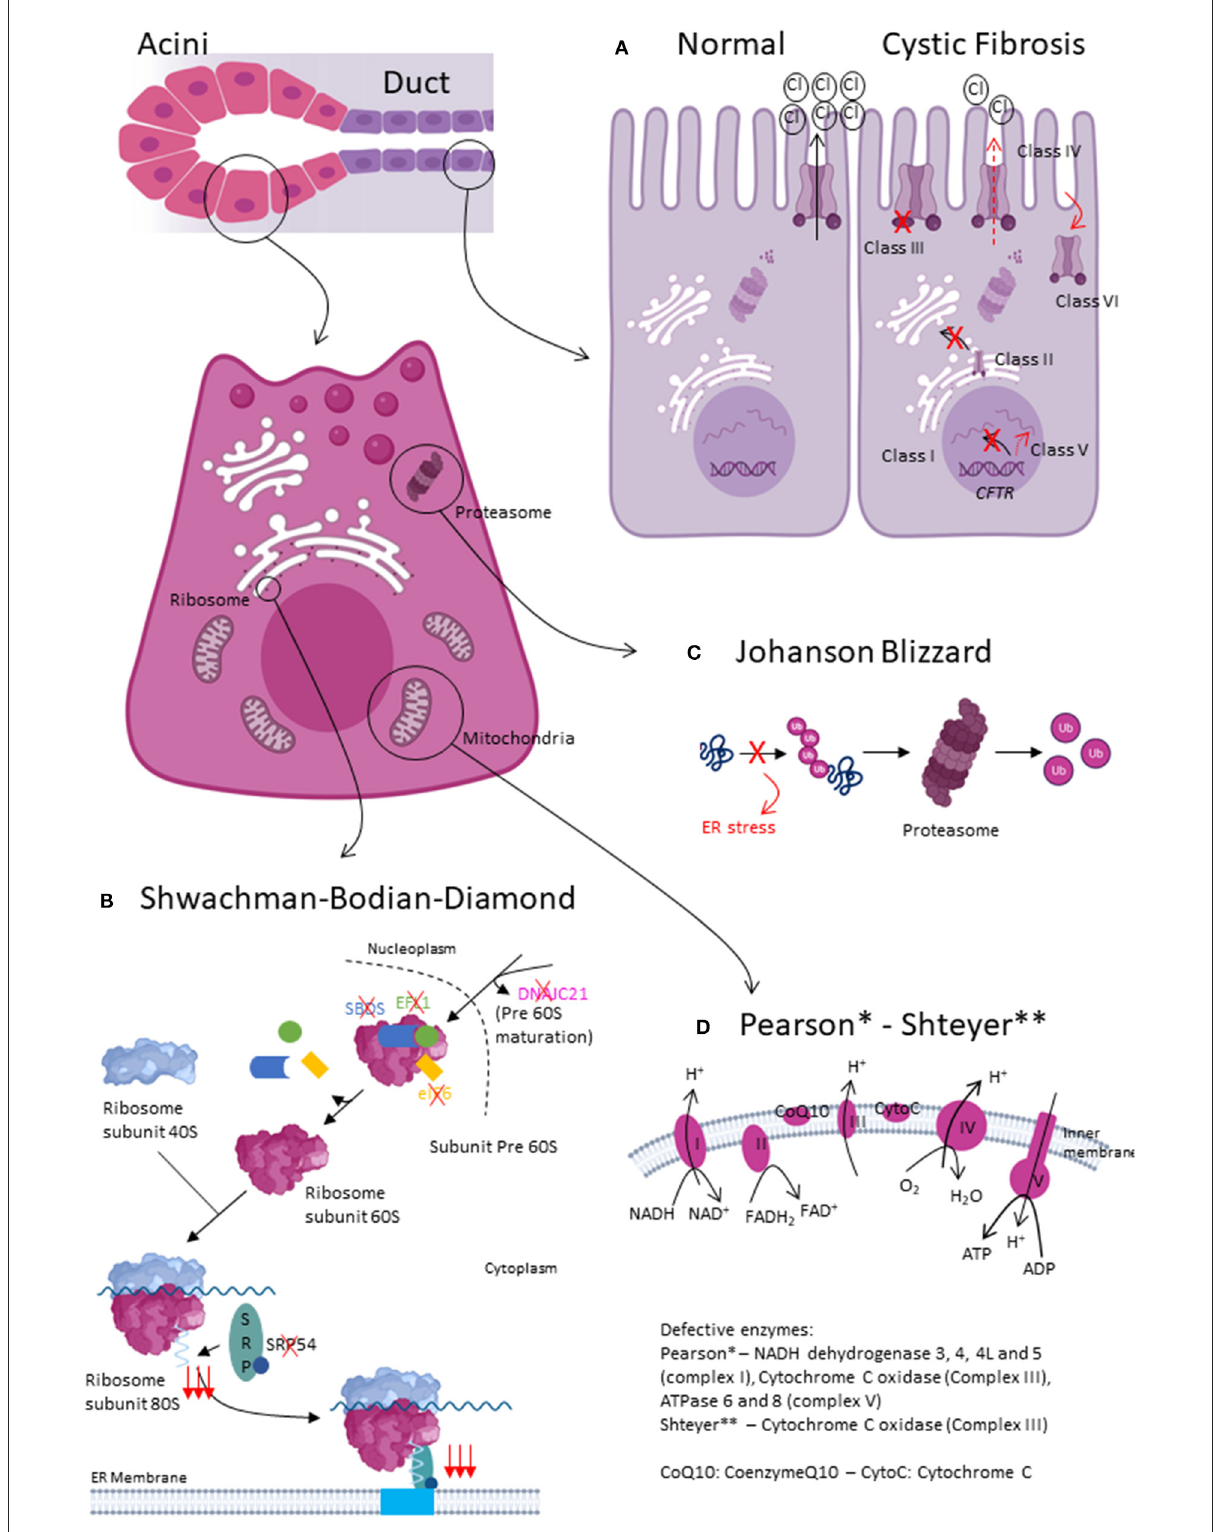
FIGURE1 Pathophysiology of exocrine pancreatic insufficiency due to pancreatic exocrine tissue injury. (A) Normal and altered CFTR function. In Class I CFTR mutations, no CFTR protein is synthetized. In Class II, CFTR protein trafficking is defective. Class III mutations lead to impaired